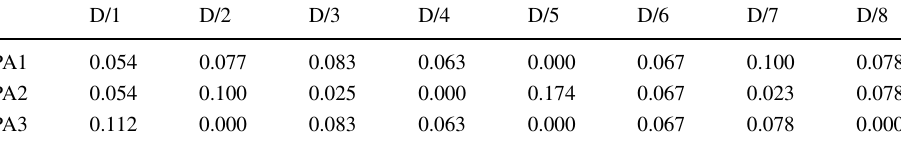
Table 15 Weighted DM